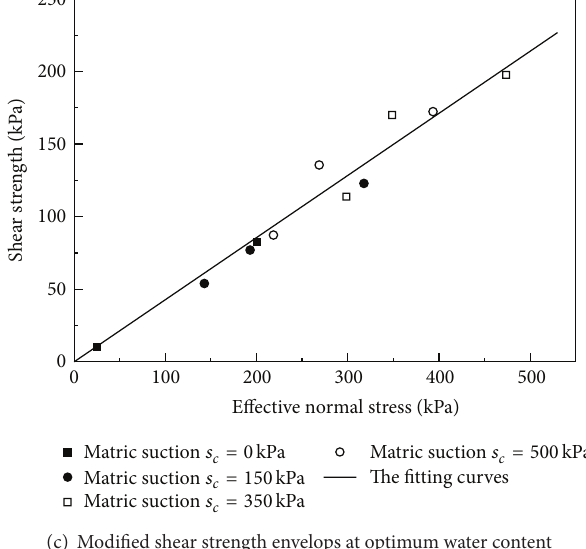
Figure 3: The curves of effective normal stress and shear strength at different initial water content state of soil (experimental data from Vanapalli et al.